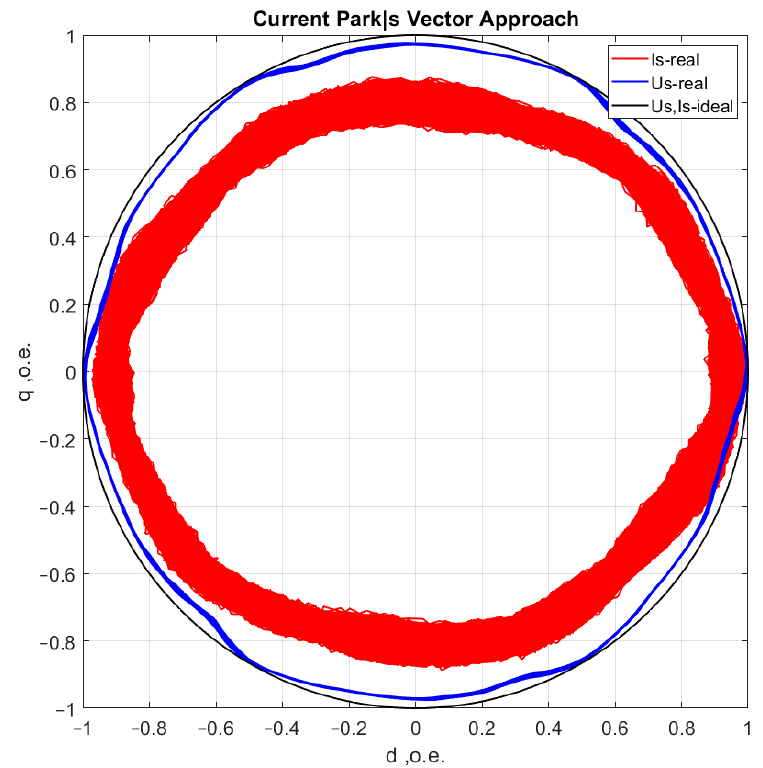
Figure 6. Reference motor operation without load at idle speed.